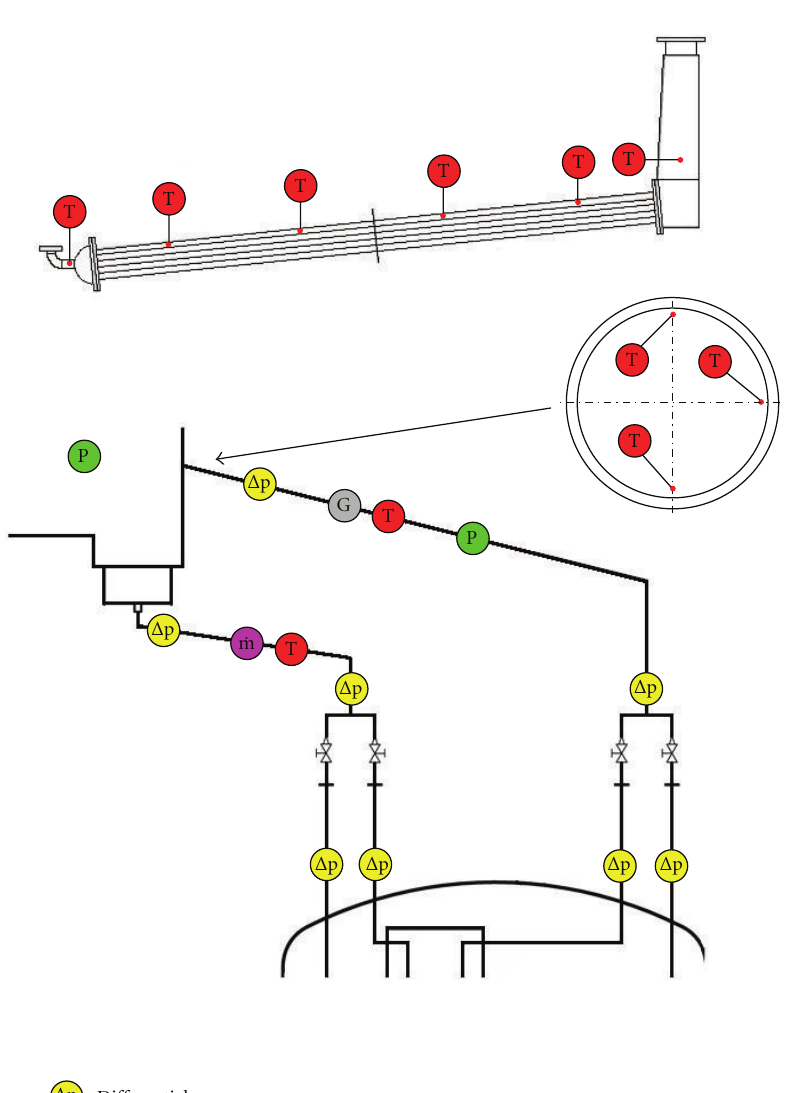
Figure 13: Instrumentation of the Containment Cooling Condenser System and